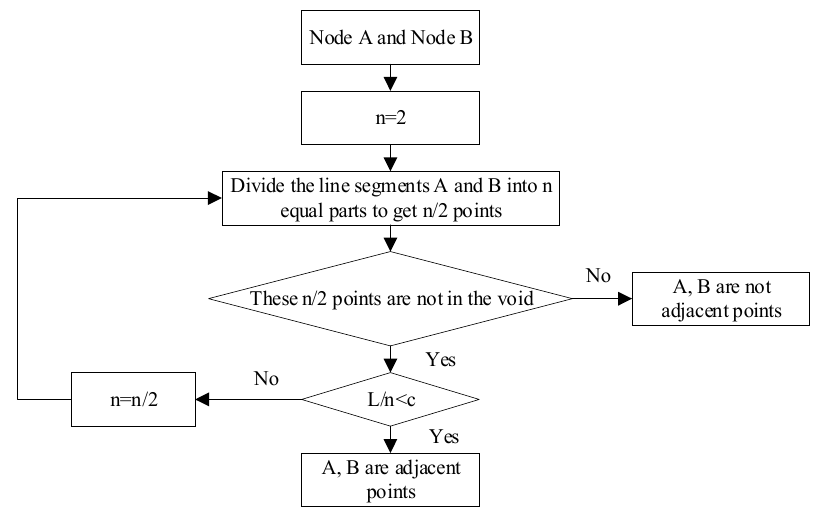
where the line segment AB is halved and quartered, respectively.